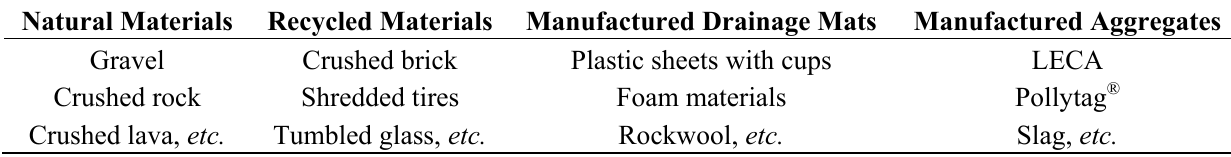
Table 3. Types and examples of drainage materials for green roofs.